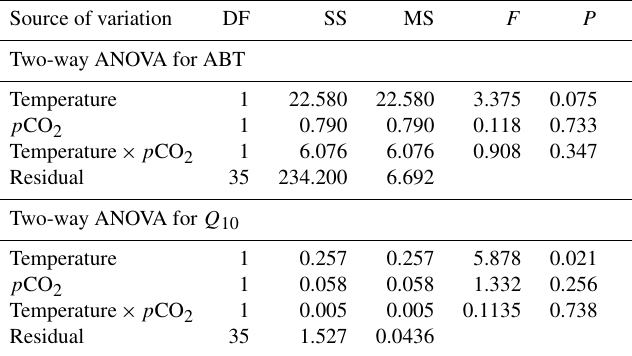
Table A3. Two-way ANOVA to investigate the effects of tempera- ture (20 and 24 ◦ C) and p CO 2 (400 and 1000ppm) on Arrhenius breakpoint temperature (ABT) of heart rate and temperature coeffi- cients ( Q 10 ) on Cellana toreuma .